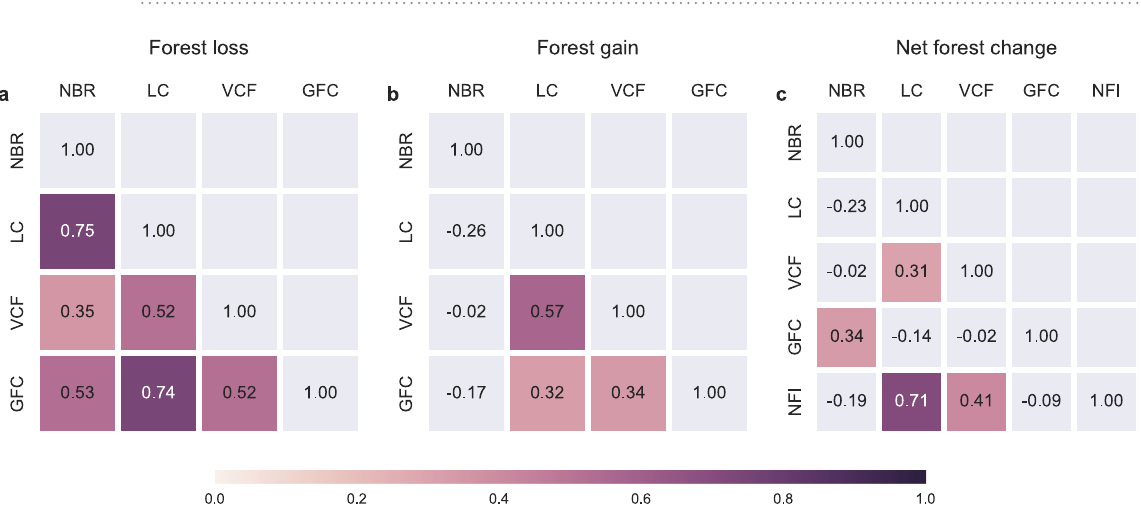
Figure 4. Net forest cover change from satellite data ( a ) MODIS NBR, ( b ) MODIS LC, ( c ) MODIS VCF, ( d ) Landsat GFC, and ( e )the Chinese National Forest Inventory (NFI) data at the provincial level (%). Provincial forest change is presented as the area of change relative to the total area of each province (%). The number in parentheses next to the title shows the corresponding net change in national forest coverage. Maps were created using Python 2.7.11 (https://www.python.org/).